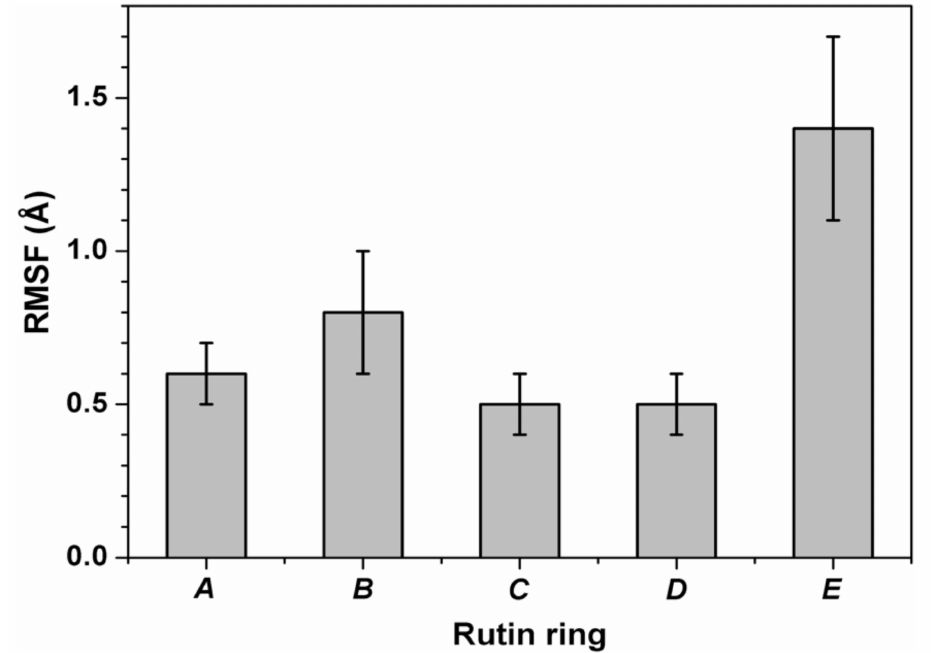
Figure 8. Root mean square fluctuations (RMSF) of the inner motion for the five rings of rutin. Rings A and C together form the connected double ring of the quercetin moiety, and rings D and E belong to the disaccharide rutinose (see also Figure 1). Values are calculated for the six non-hydrogen atoms forming each ring. Error bars indicate the uncertainties in terms of standard